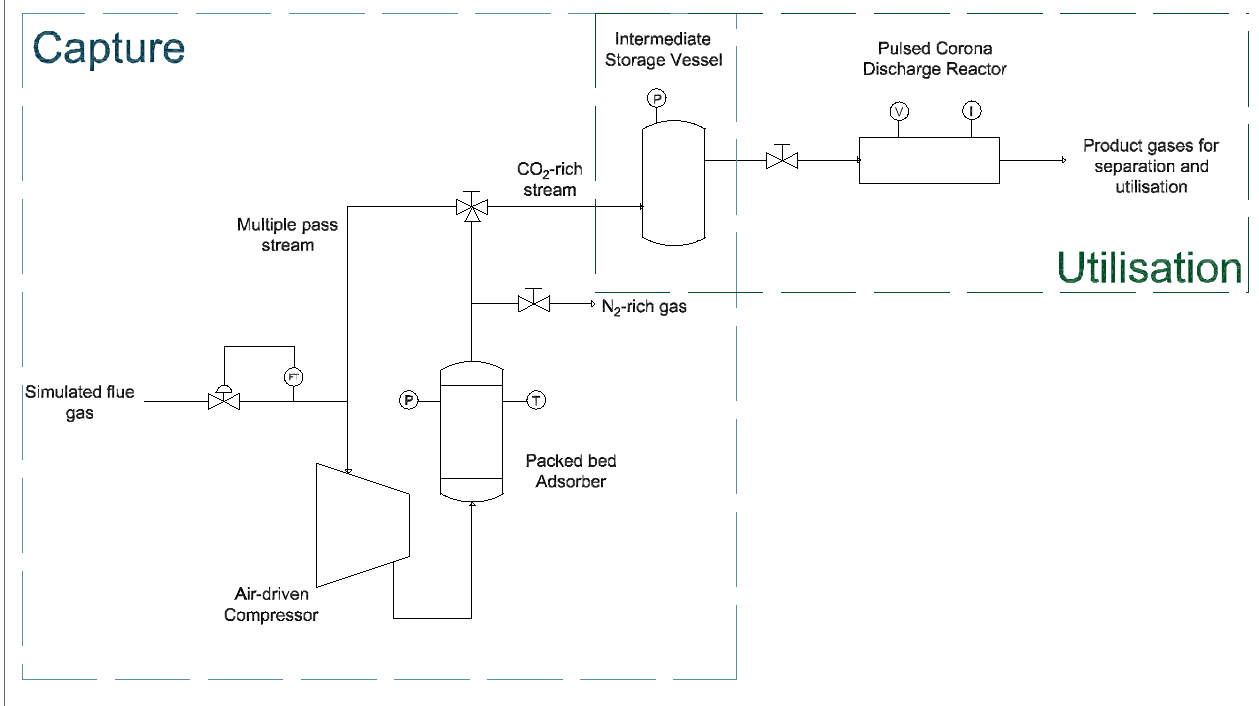
FigUre 8 | Proposed system for integrated CO 2 capture and